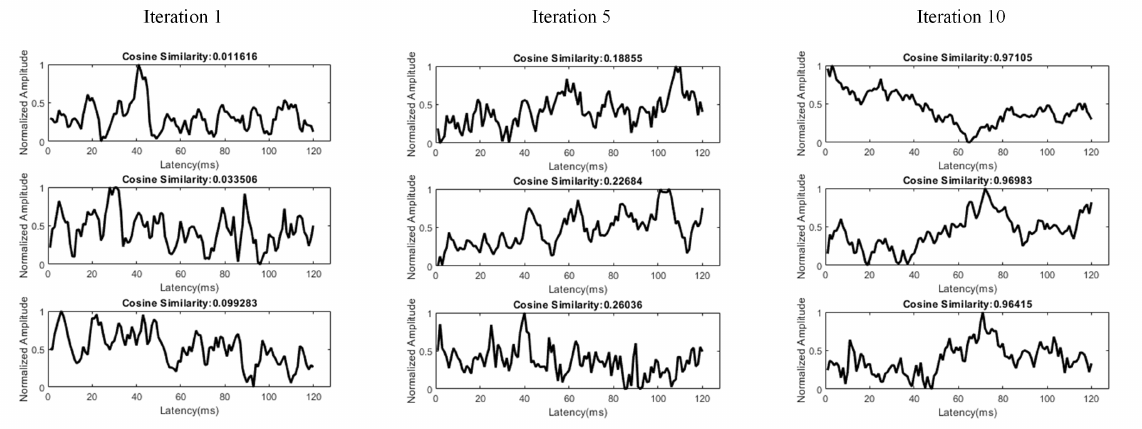
Figure 1. Dictionary atom learning example in K-SVD algorithm after several iterations. The cosine similarity shows the similarity between the atom and the target ERP